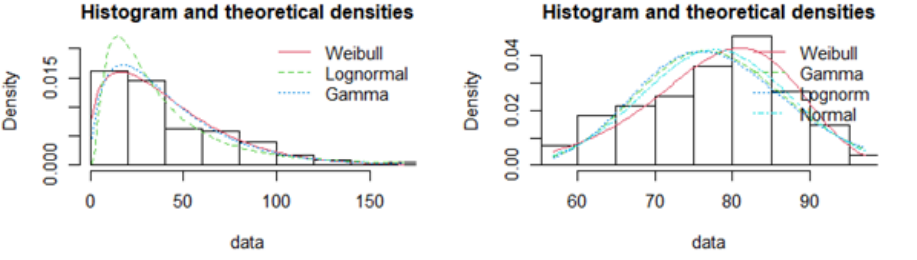
Figure 1. Example Distribution Estimation of a Datasets